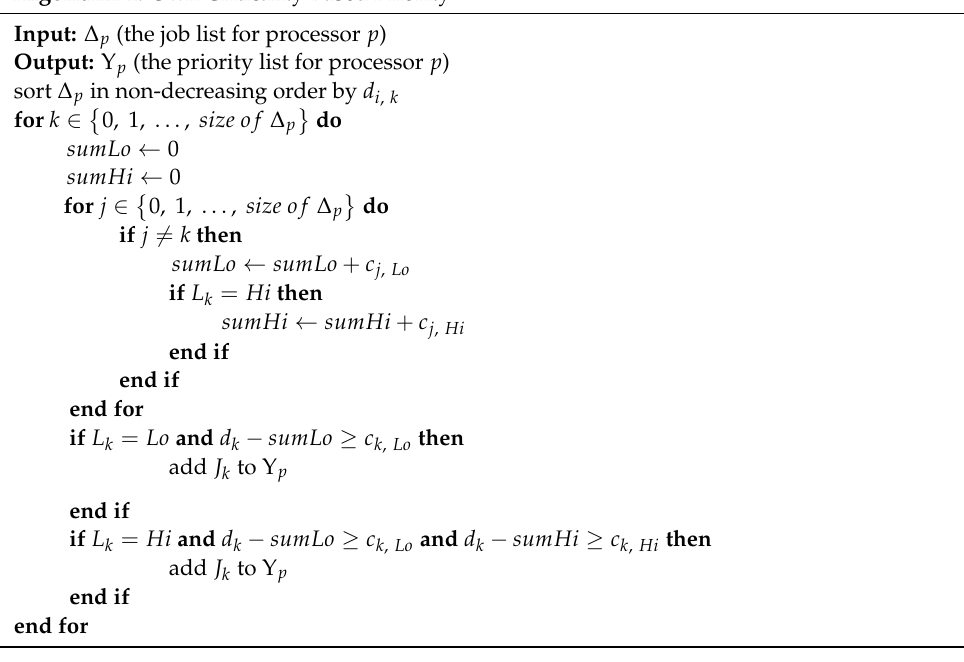
Algorithm 1: Own Criticality Based